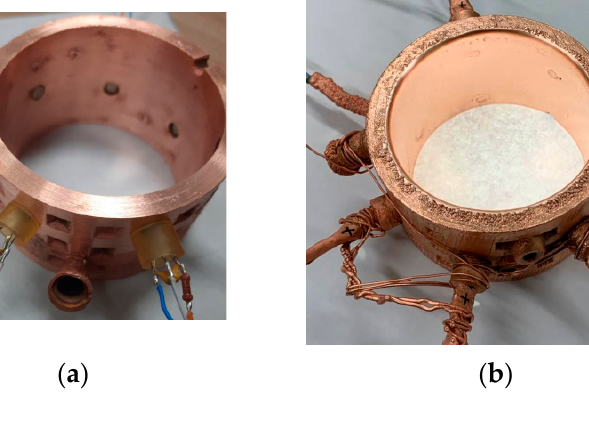
Figure 9. Collector sections having copper thickness of ( a ) 1 mm and ( b ) 2 mm; ( c ) installed heat- insulated thermal sensors.